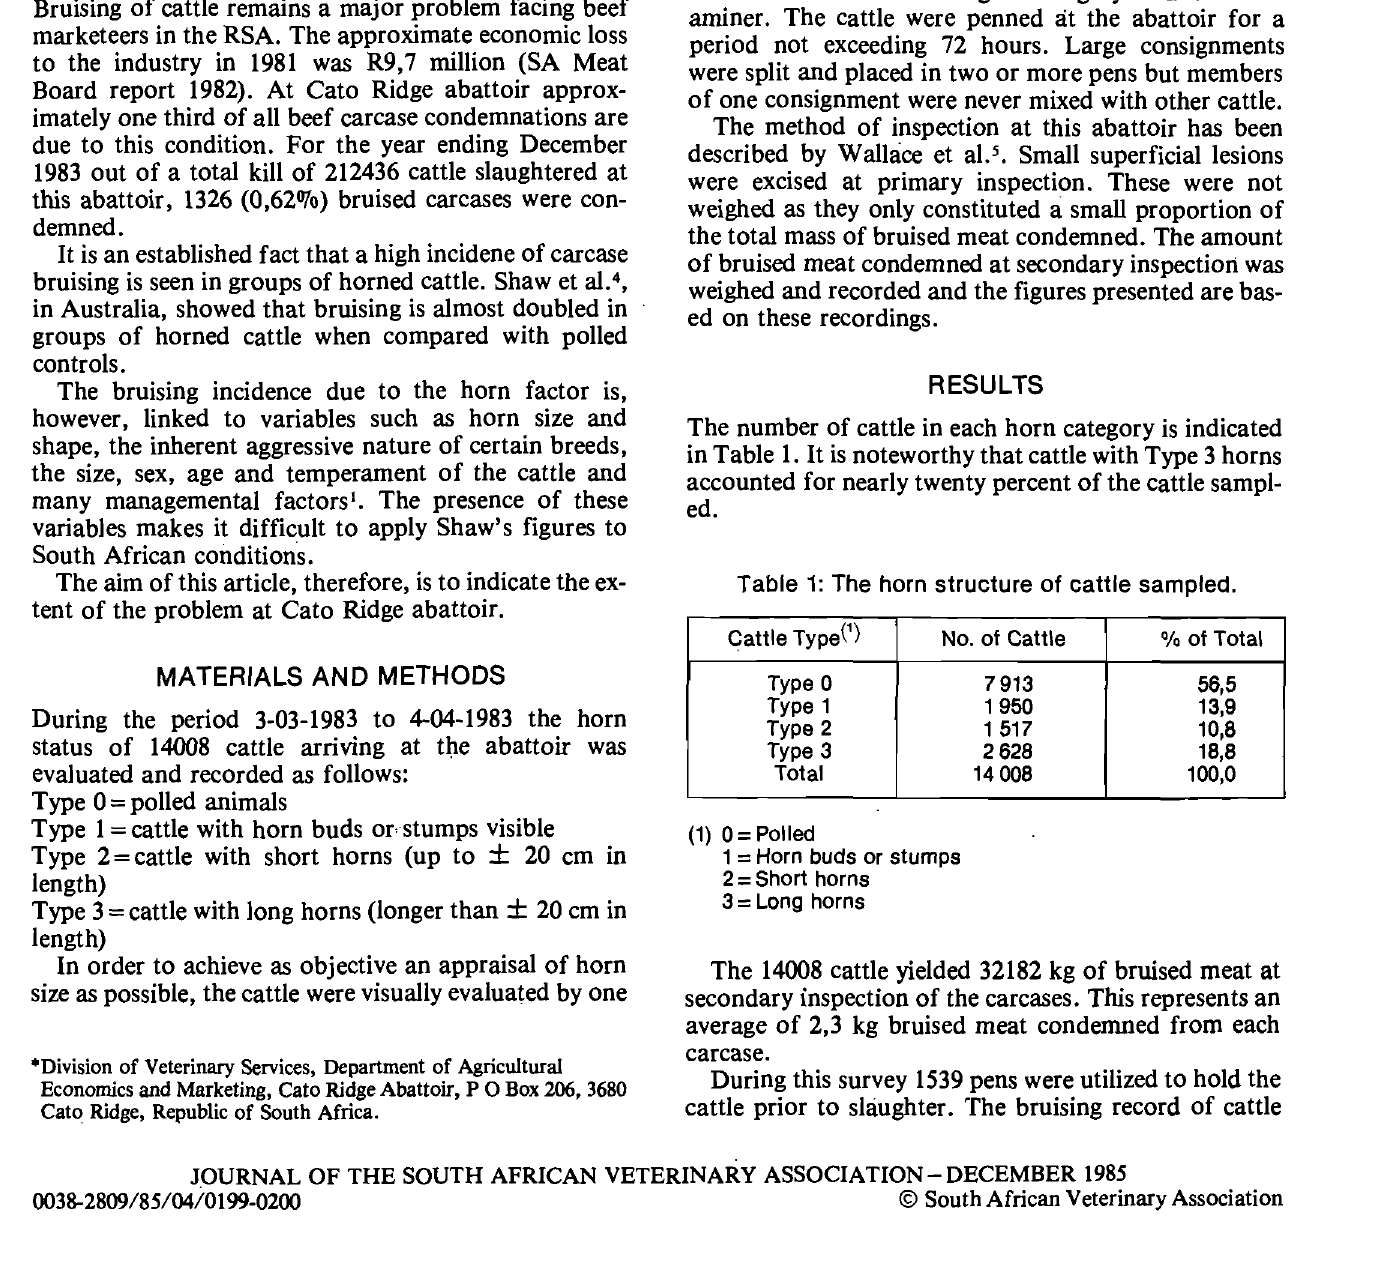
Table 1: The horn structure of cattle sampled. Cattle